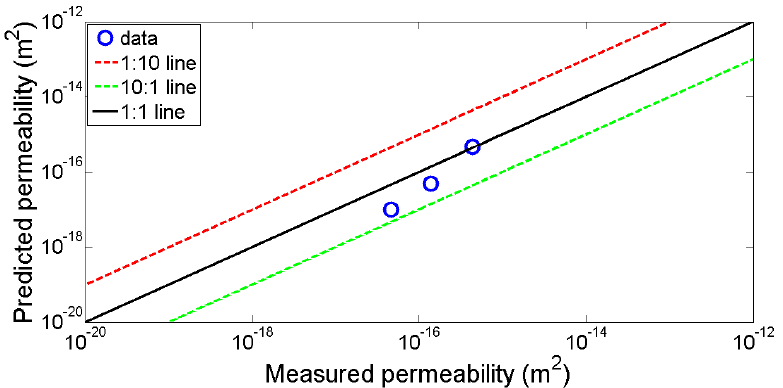
Figure 8. Comparison between measured permeability and calculated one for three fractured limestone samples obtained from [102] using Equation